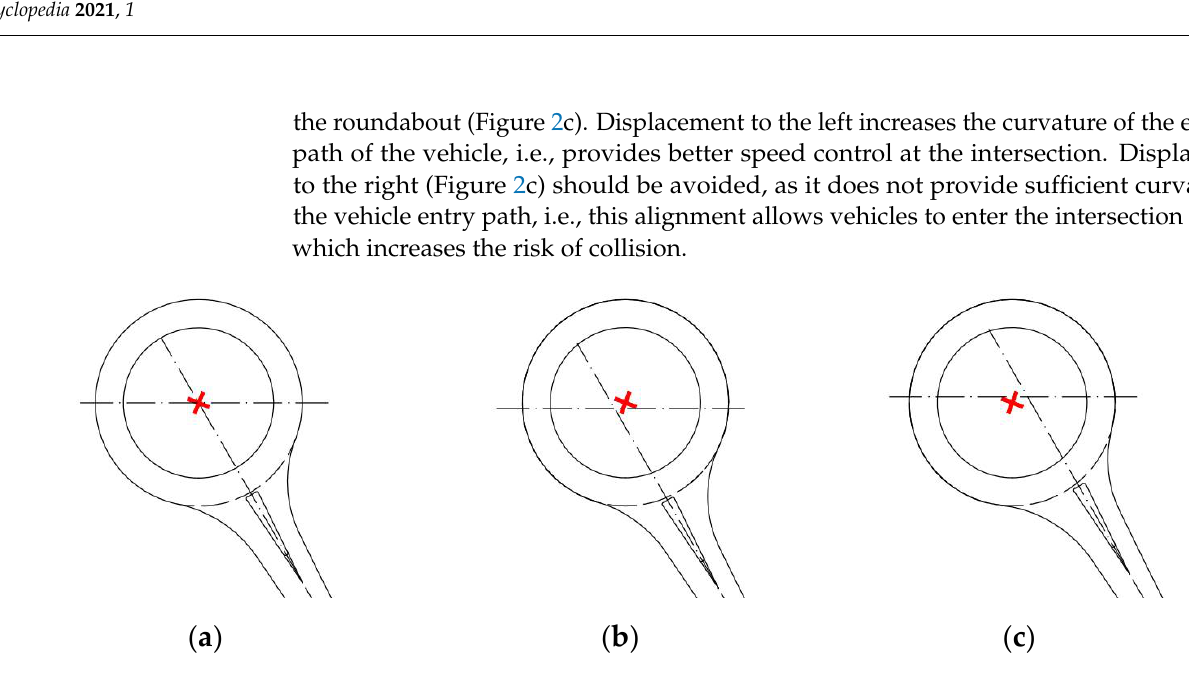
Figure 2. The approach alignment variants according to [8]: ( a ) radial alignment geometric elements of single-lane roundabouts, ( b ) displacement to the left, and ( c ) displacement to the right. The red “ × ” marks the center of the roundabout outer radius.